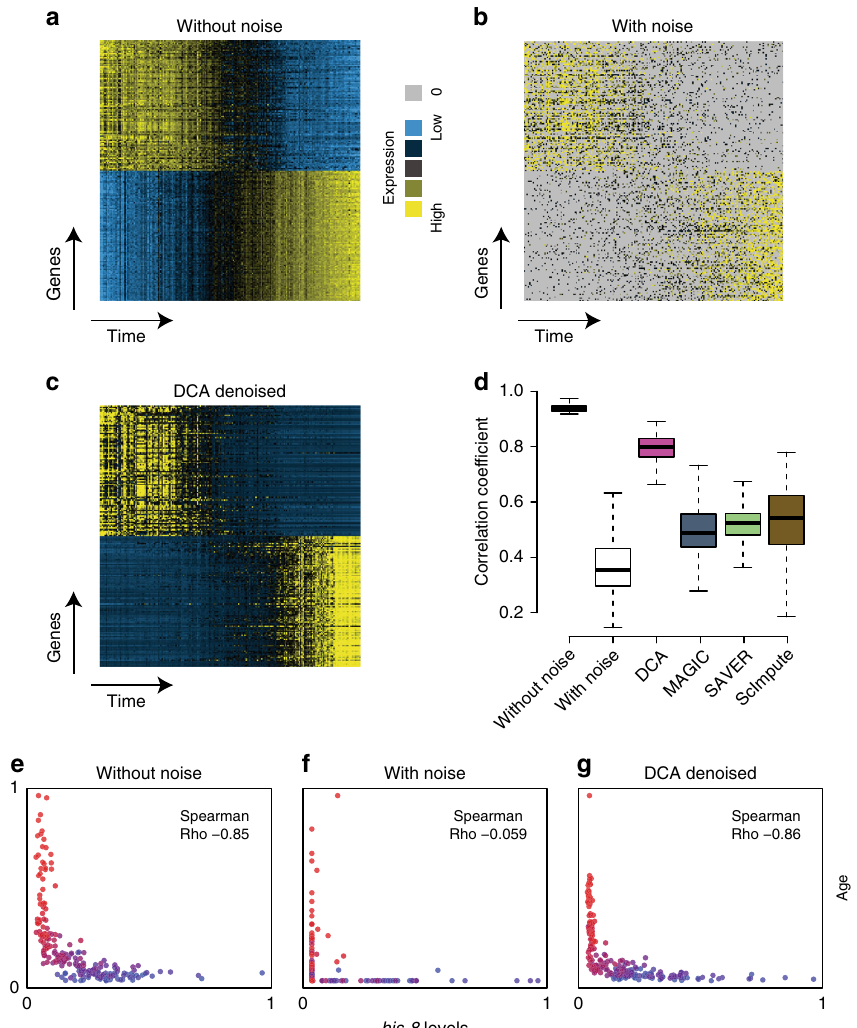
Fig. 4 DCA recovers gene expression trajectories in C . elegans time course experiments with simulated dropout. Heatmaps show the top 100 genes with positive and negative association with time course using expression data without noise ( a ), with noise ( b ) and after DCA denoising ( c ). Yellow and blue colors represent relative high and low expression levels, respectively. Zero values are colored grey. Distribution of Pearson correlation coef fi cients across the 500 most highly correlated genes before noise addition for the various expression matrices are depicted in d . The box represents the interquartile range, the horizontal line in the box is the median, and the whiskers represent 1.5 times the interquartile range. Panels e – g illustrate gene expression trajectory for exemplary anti-correlated gene pair tbx-36 and his-8 over time for data without, with noise and after denoising using